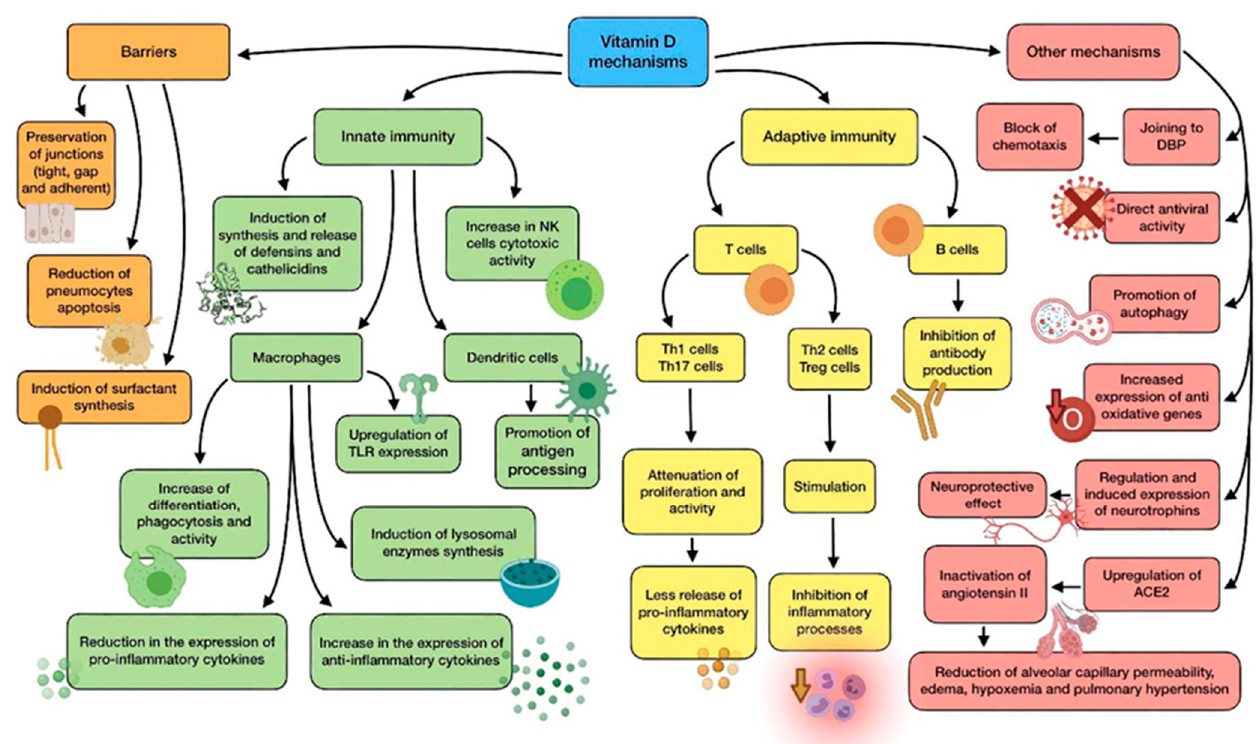
Figure 2. Summary of vitamin D main mechanisms of